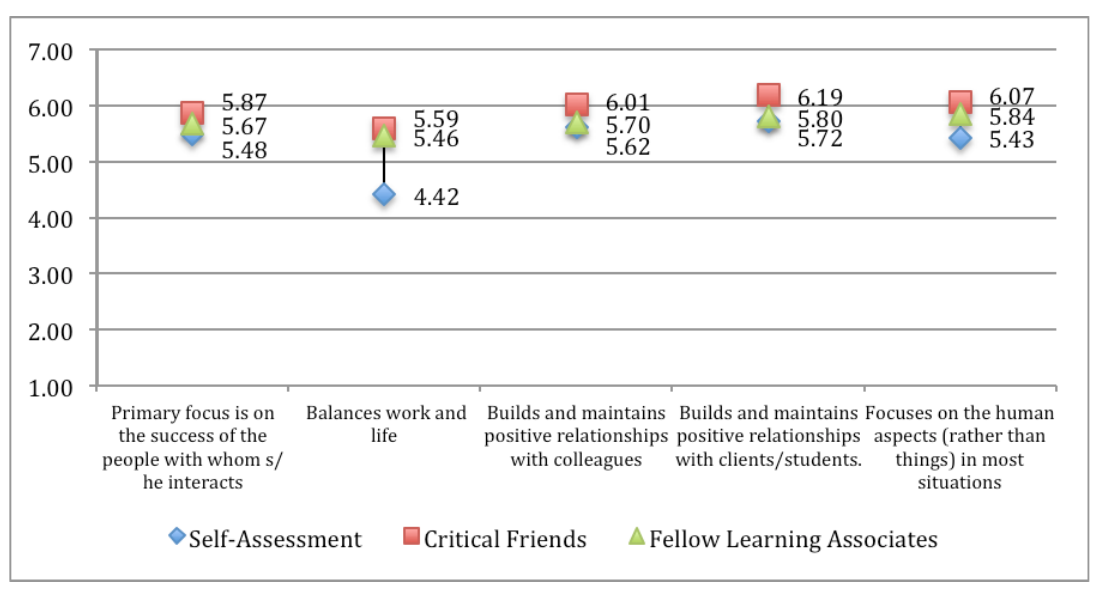
Figure 7. Frame of Reference. Self-Assessment N=74, Critical Friends N=573, Fellow Learning Associates